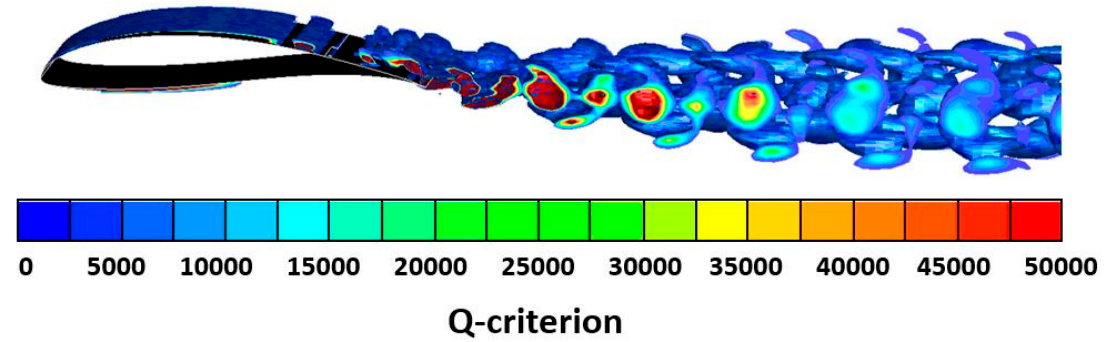
◦ angle of attack.